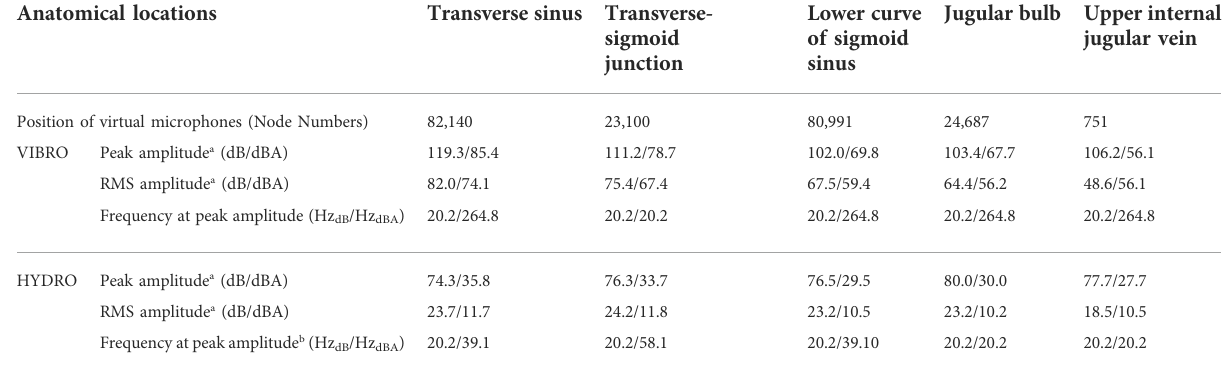
TABLE 3 Results of acoustic pro fi les measured at different anatomical